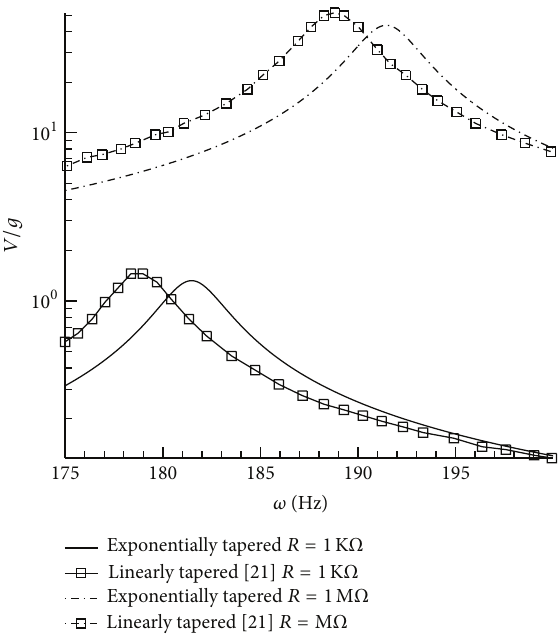
Figure 15: Tapering and electric resistance effects on bimorph with parallel connection.